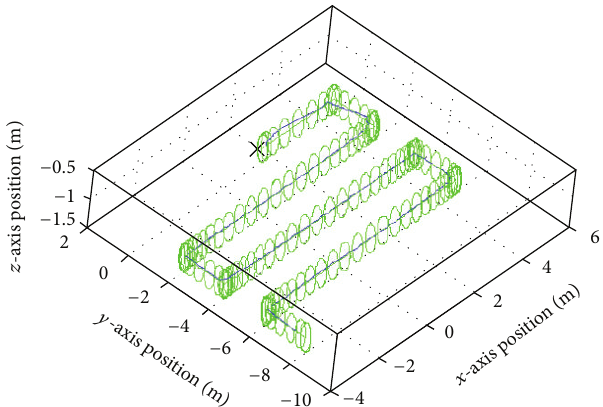
Figure 5: Three-dimensional view for the nonlinear 𝐻 ∞ optimal control law with region function formulation.